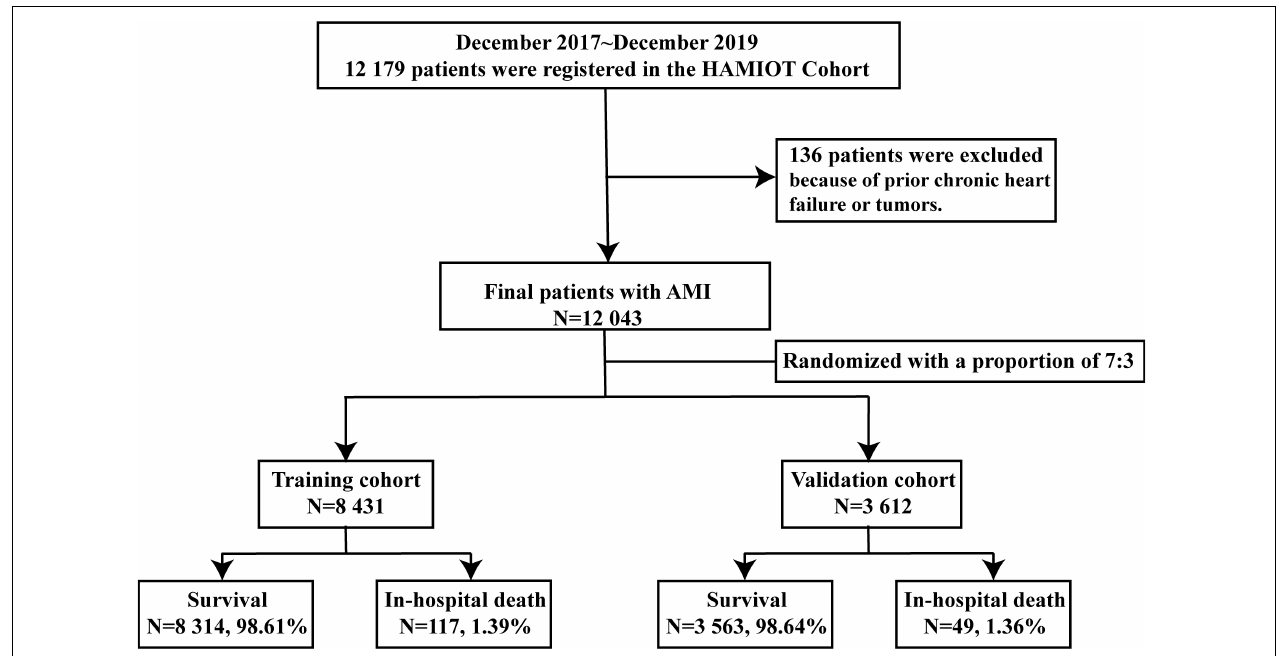
FIGURE 1 | Study flow chart of the HAMIOT Cohort Study. From December 2017 to December 2019, 12,043 patients with AMI were randomly assigned into the training ( n = 8,431) and validation ( n = 3,612) cohorts. HAMIOT, the Heart failure after Acute Myocardial Infarction with Optimal Treatment; AMI, acute myocardial